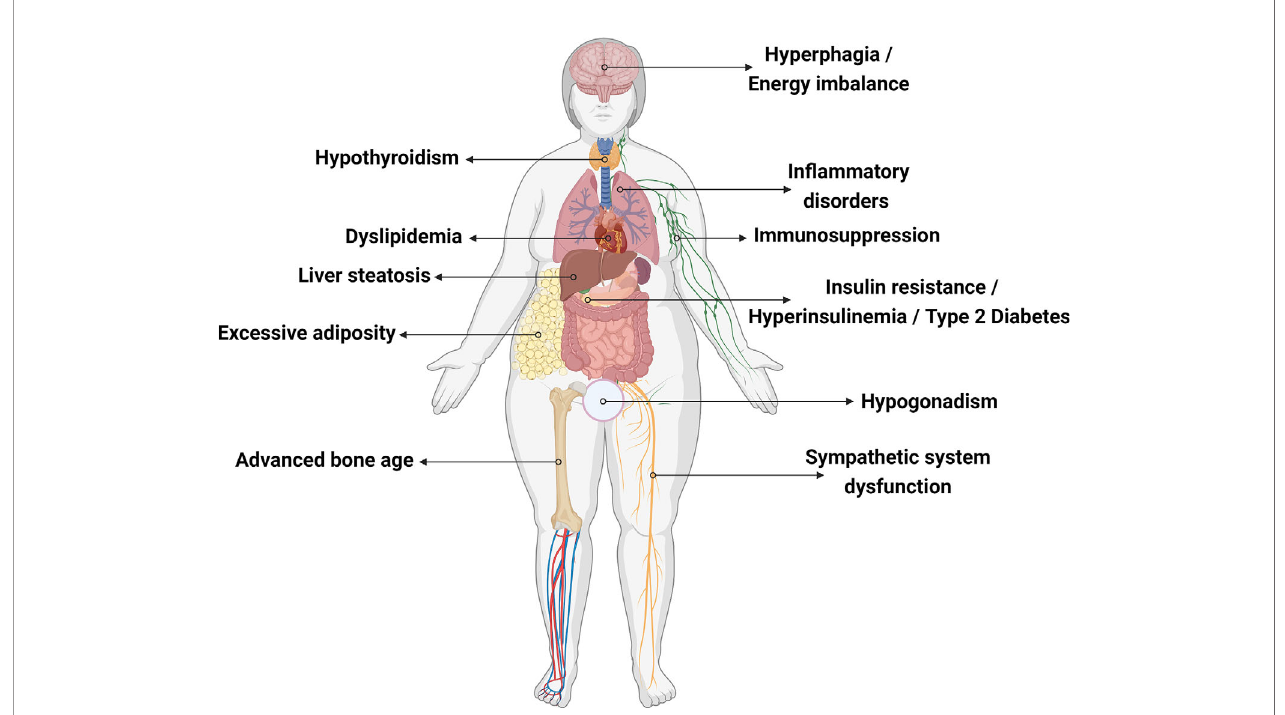
FIGURE 2 | Effects of leptin de fi ciency on human body. Created with